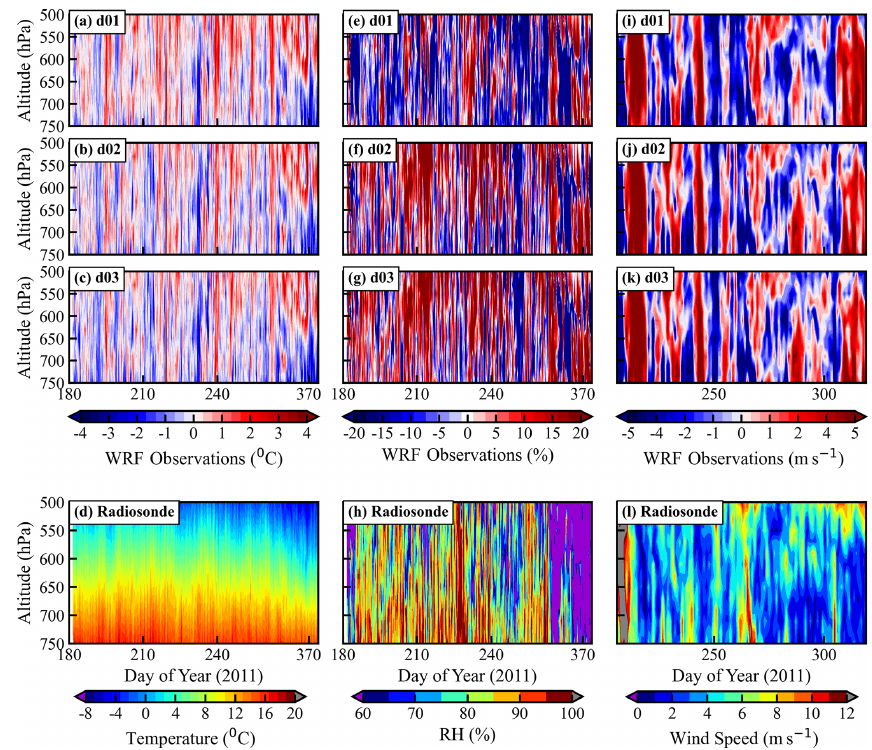
Figure 4. Difference between model (d01: first row, d02: second row, d03: third row) and radiosonde observations for temperature (a, b, c) , relative humidity (e, f, g) , and wind speed (i, j, k) profiles up to 500hPa. The fourth row provides the vertical profiles of radiosonde measurements. The x axis in panels (a–h) shows the day of the year in 2011 from 1 July (182nd day) to 30 September (273rd day). Wind speed (ms − 1 ) profiles in panels (i–l) are provided for September